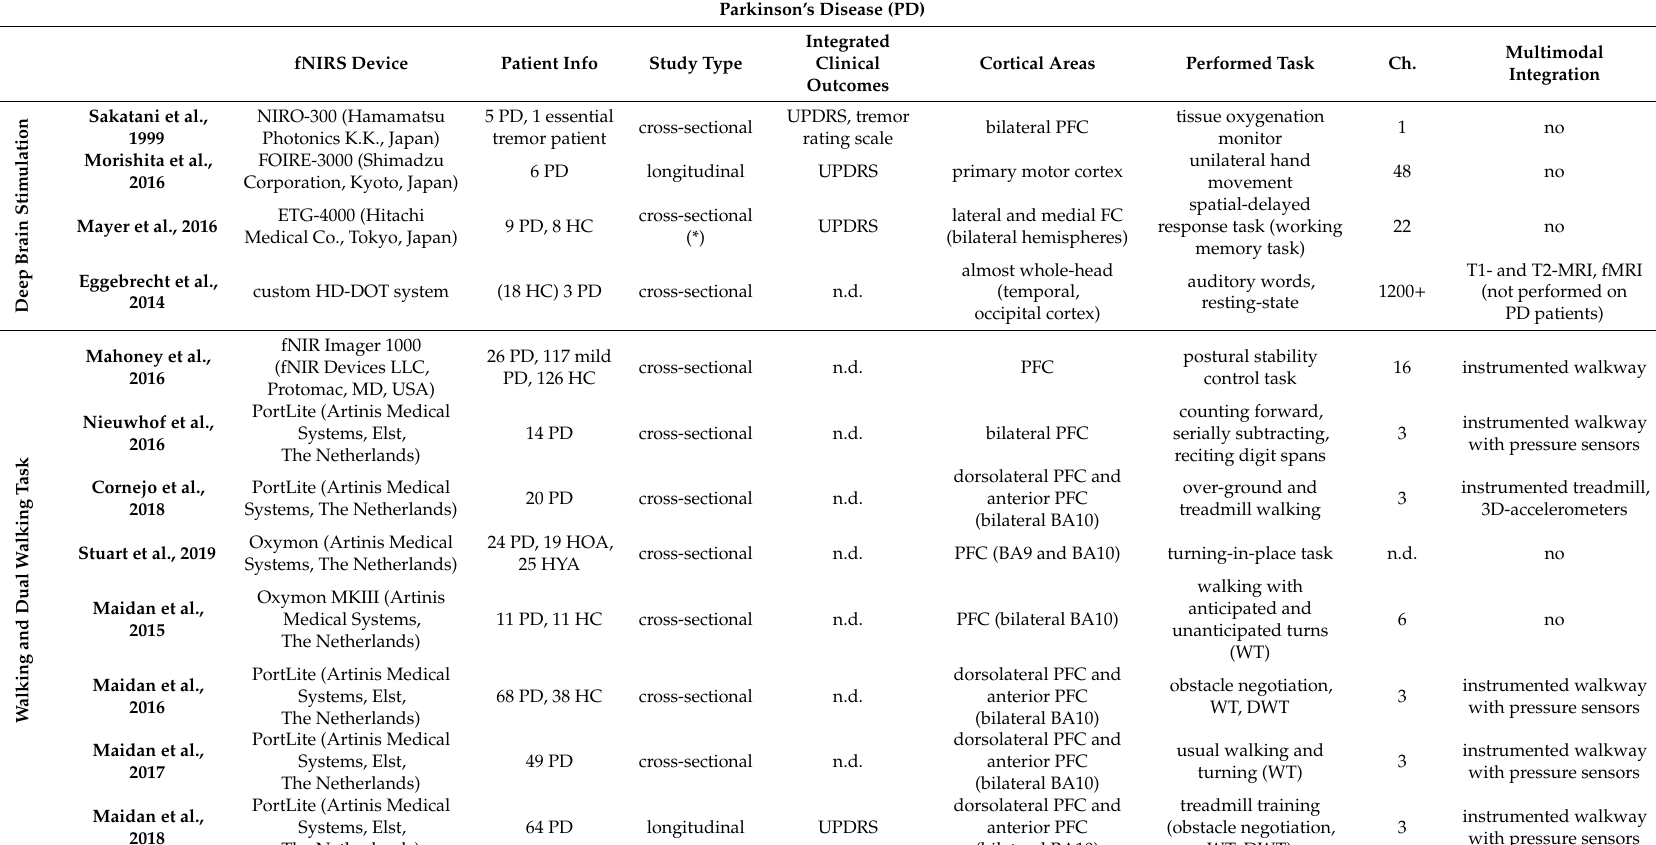
Table 1. Summary of peer-reviewed articles of functional Near-Infrared Spectroscopy (fNIRS) applications in Parkinson’s Disease (PD) patients found trough literature search of NCBI PubMed and Web of Science